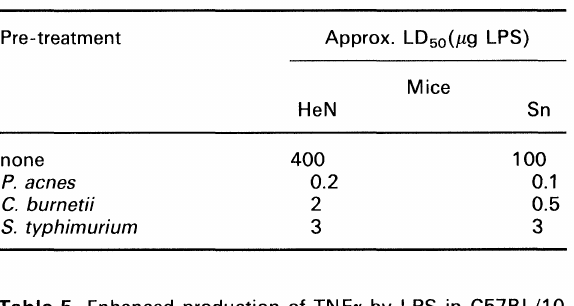
Table 5. Enhanced production of TNF by LPS in C57BL/10 ScSn mice treated with bacteria